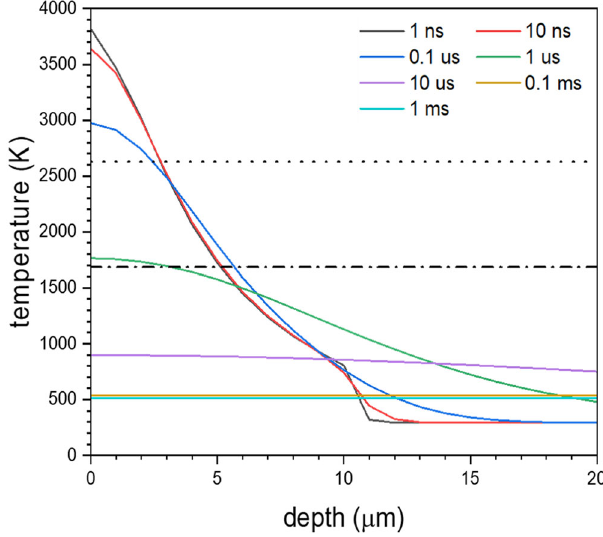
Fig. 4 Simulations of the silicon sample temperature as a function of depth for a series of time steps following a laser-ion pulse. Details of the energy deposition to temperature pro fi le calculations are provided in the Supplementary Note 3. The dash-dot line shows the melting temperature of silicon of 1683 K; the dotted line shows the boiling temperature of silicon of 2628